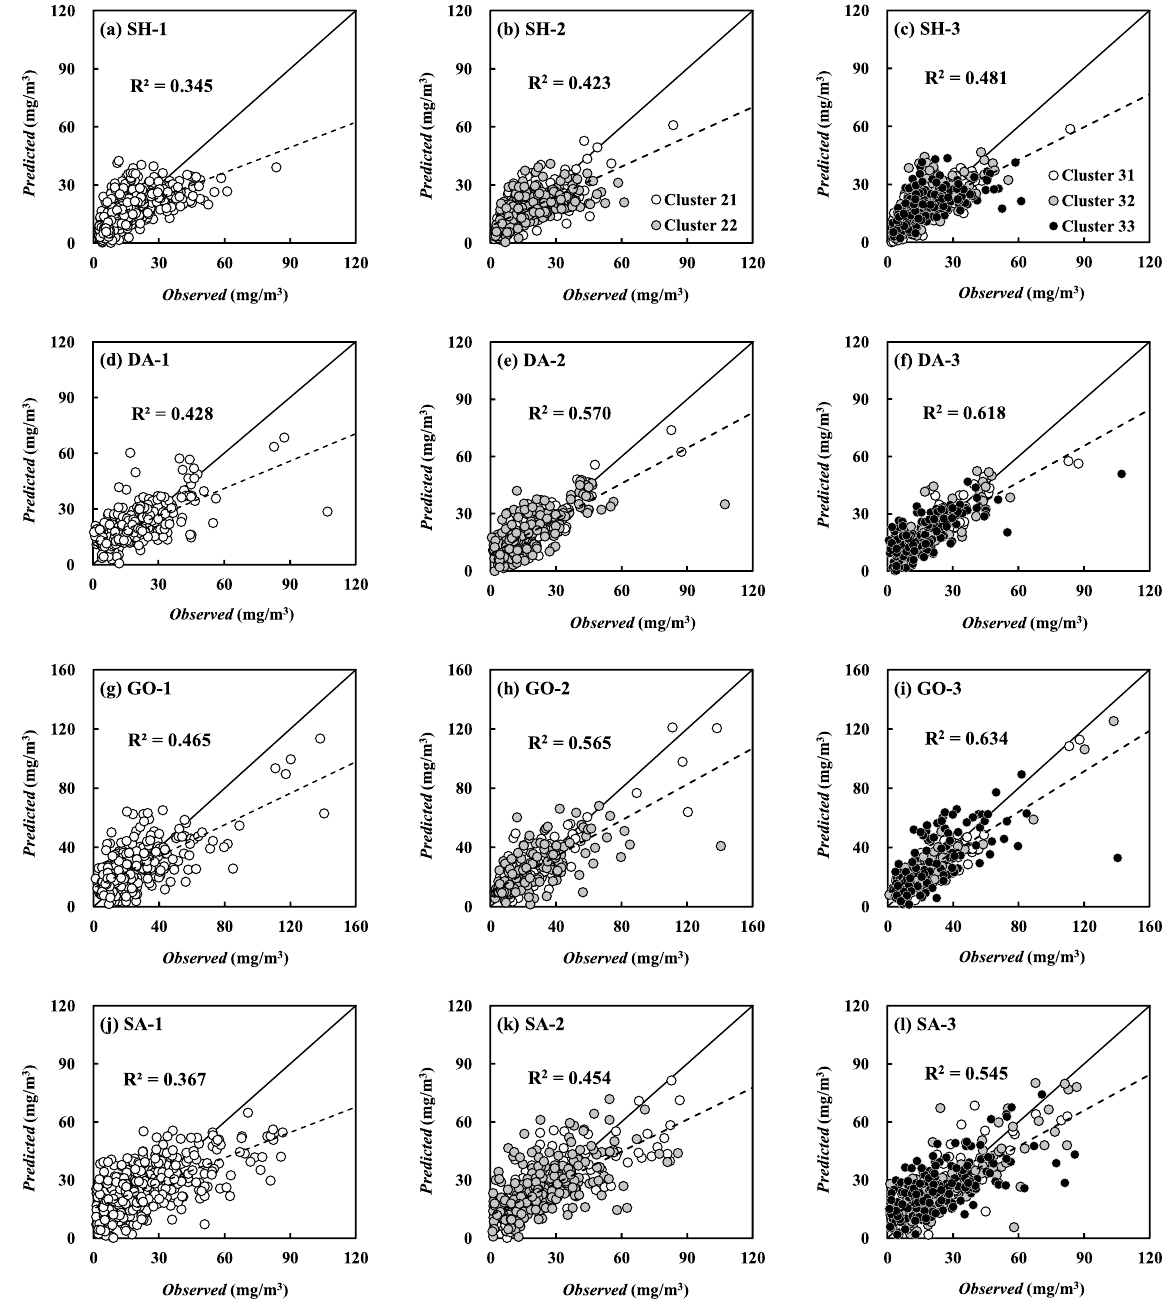
Figure 2. Testing results of Chl-a prediction with trained non-clustered, 2-cluster and 3-cluster ANN models (the solid line and dotted line indicate a 1:1 linear line and a fitting line to predictions,